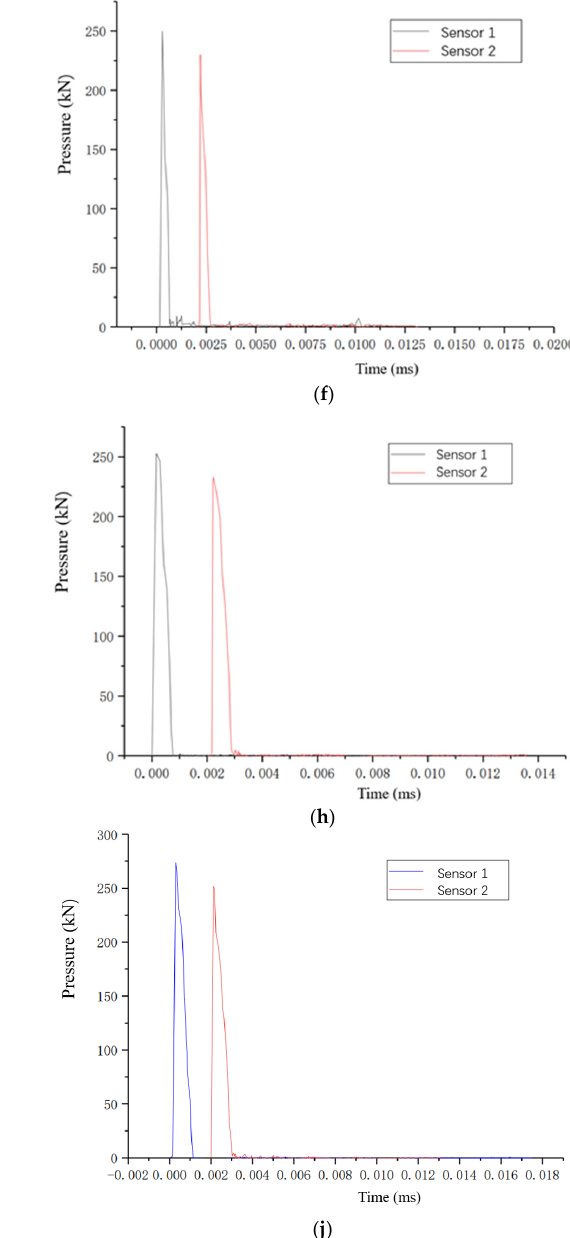
Figure 7. Time history curve of plane explosive wave pressure: ( a ) 0%SFRC pressure time course curve under 24 g RDX; ( b ) 0%SFRC pressure time history curve under 36 g RDX; ( c ) 0.5%SFRC pressure time course curve under 24 g RDX; ( d ) 0.5%SFRC pressure time history curve under 36 g RDX; ( e ) 1%SFRC pressure time course curve under 24 g RDX; ( f ) 1%SFRC pressure time history curve under 36 g RDX; ( g ) 1.5%SFRC pressure time course curve under 24 g RDX; ( h ) 1.5%SFRC pressure time history curve under 36 g RDX; ( i ) 2%SFRC pressure time course curve under 24 g RDX; ( j ) 2%SFRC pressure time history curve under 36 g RDX. After testing, the SFRC compressive strengths of 24 g of black gold (RDX) detonated by detonator with steel fiber contents of 0%, 0.5%, 1%, 1.5%, 2%, respectively, are as follows: The compressive strength of SFRC was 69.99 MPa, 76.39 MPa, 83.68 MPa, 89.48 MPa, 97.83 MPa, and 36 g of black gold (RDX).The compressive strengths of SFRC with steel fiber content of 0%, 0.5%, 1%, 1.5%, and 2% under the action of 36 g of black sorghum (RDX) were 111.38 MPa, 120.34 MPa, 127.19 MPa, 127.19 Mpa, 128.73 MPa, and 139.41 MPa respectively. The dynamic strengthening factors are shown in Figure 8.